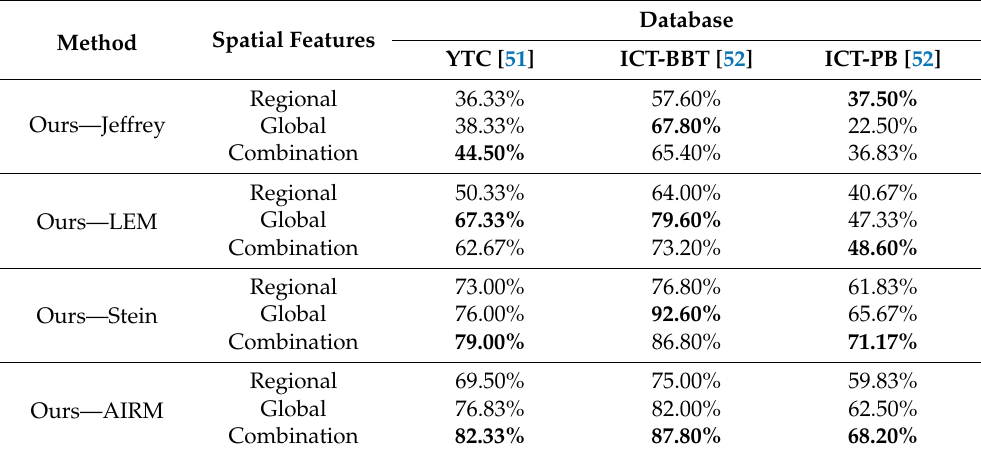
Table 2. Recognition results with global spatial features and regional spatial features.